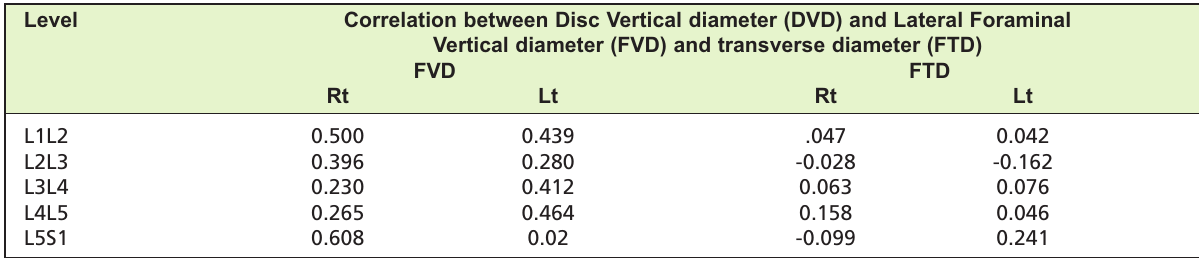
transverse diameter (FTD)